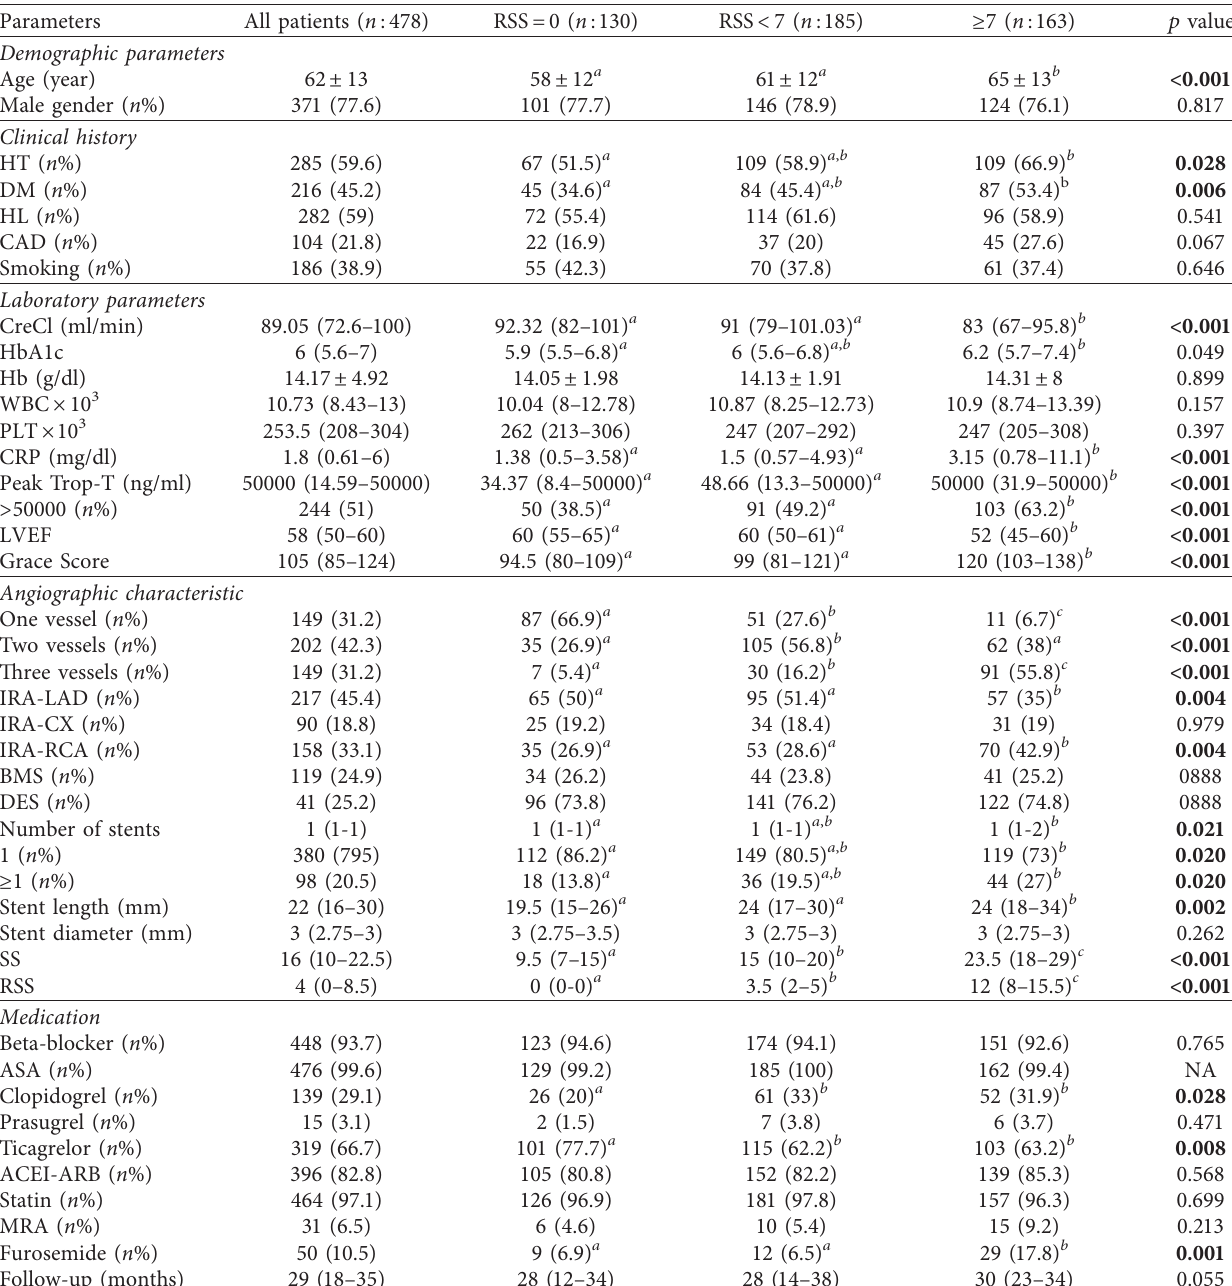
Table 3: Long-term demographic, clinical, laboratory, and procedural characteristics, medication, and scores of